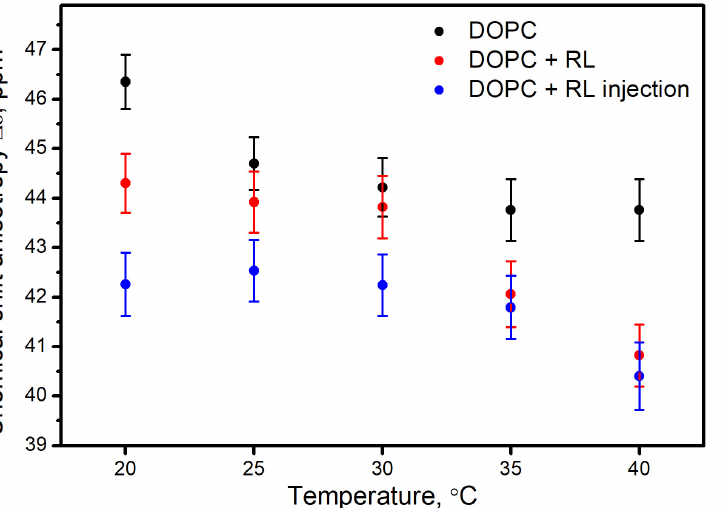
Figure 3. Temperature dependence of chemical shift anisotropy parameter ∆ δ for liposomes from DOPC ( • ), for liposomes prepared from a mixture of DOPC and rhamnolipids ( • ) and for liposomes from DOPC with rhamnolipids injection ( •